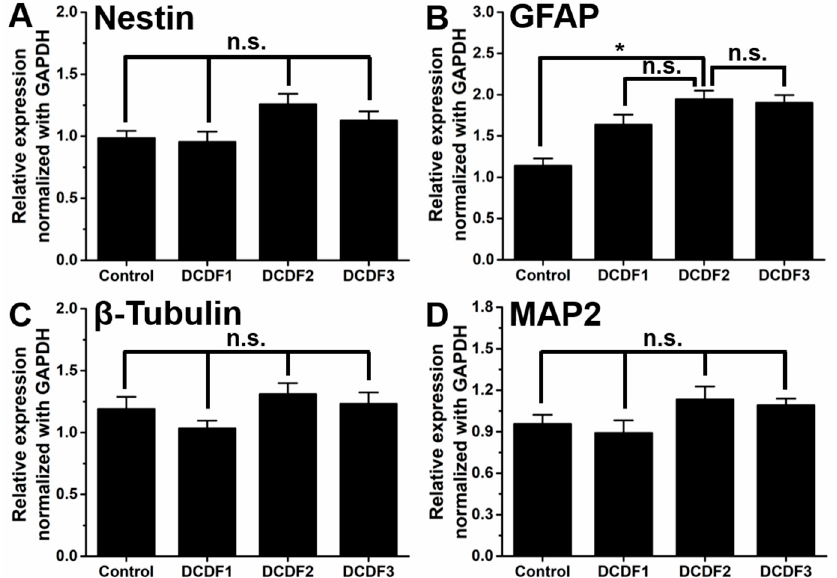
Figure 9. The differentiation of NSCs on DCDFs. The gene expressions of neural-related genes, including ( A ) Nestin, ( B ) GFAP, ( C ) β -tubulin, and ( D ) MAP2, were analyzed by RT-PCR at 4 days. The expression levels are represented by the relative ratios of gene expression normalized to that of GAPDH. * p < 0.05 between the indicated groups. Control group: thin films without DCP.